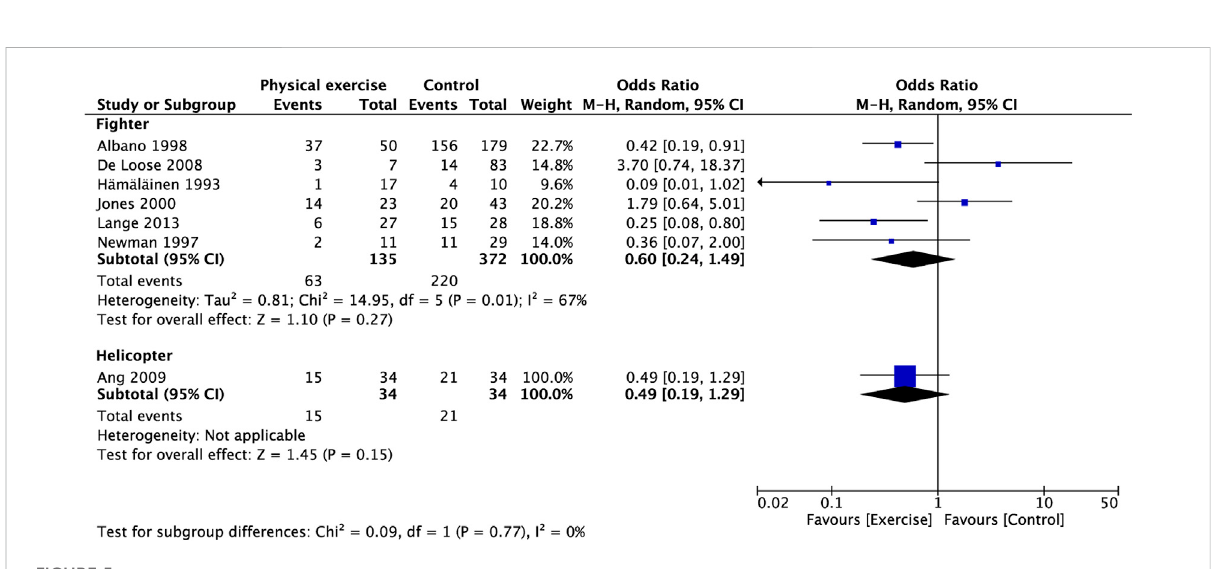
FIGURE 5 Subgroup analysis for prevalence of neck pain (type of